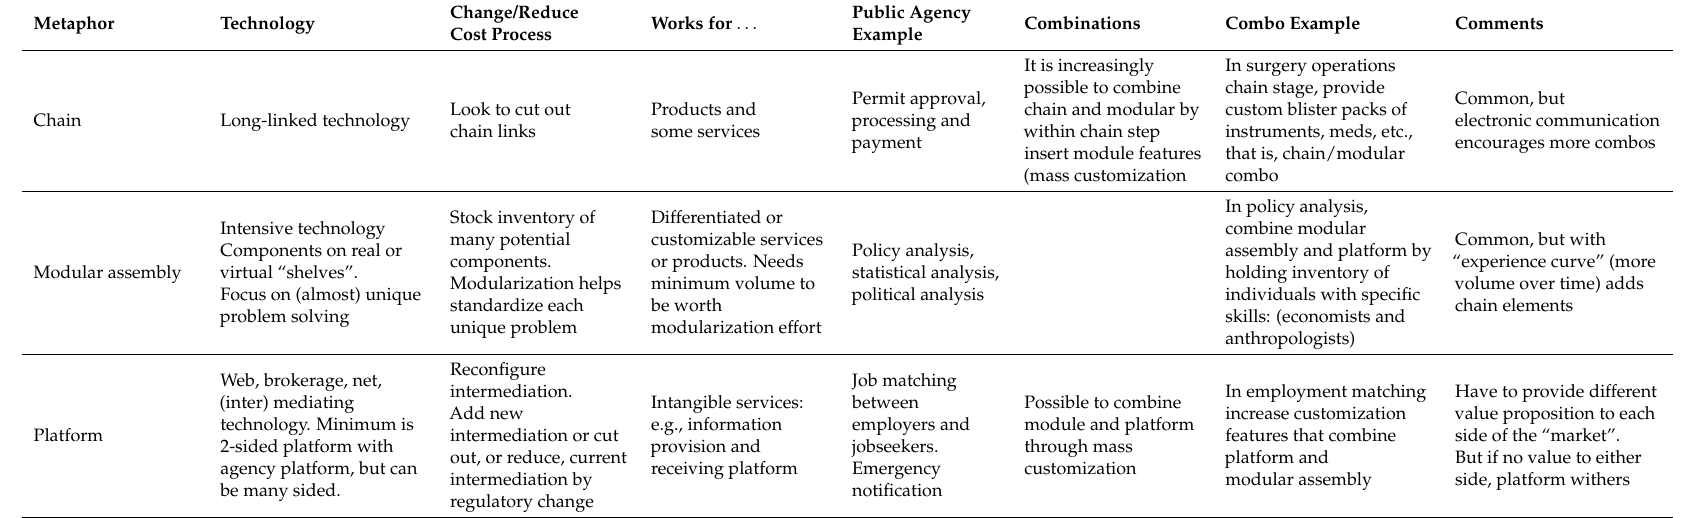
Table 1. Three PASA Value Creation Metaphors/Models for Internal